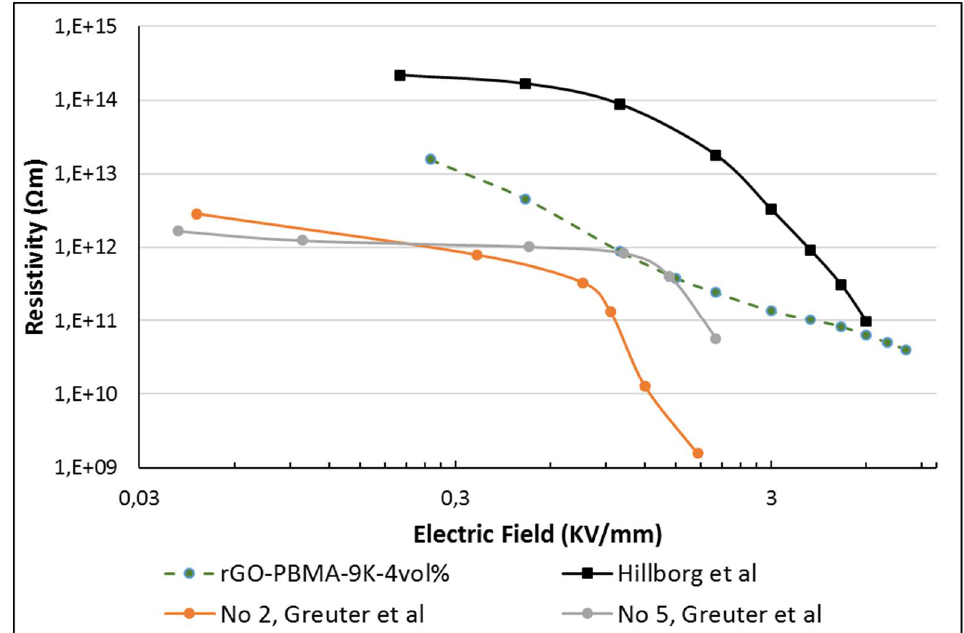
Figure 6. Comparison of non-linear resistivity of rGO-PBMA-9k with literature data. The commercial grade field grading materials (No. 2 and 5 in Greuter et al. [6]) exhibit a significantly lower resistivity at the lower fields, and higher non-linearity, compared to rGO-PBMA-9k. A field grading material based on 1.5 vol.% rGO in silicone rubber, reported by Hillborg et al. [24] exhibits a higher resistivity.